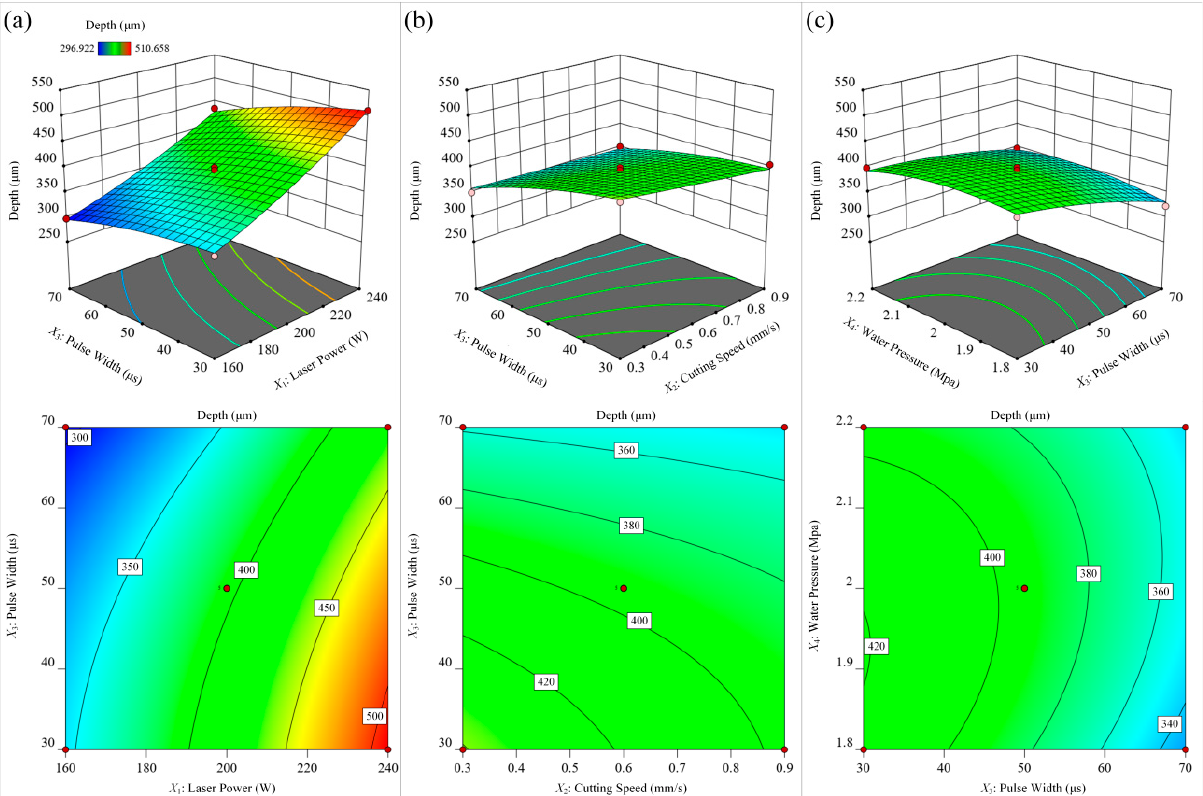
Figure 14. The influence of different process parameters on the depth. ( a ) laser power and pulse width; ( b ) cutting speed and pulse width; ( c ) pulse width and water pressure.